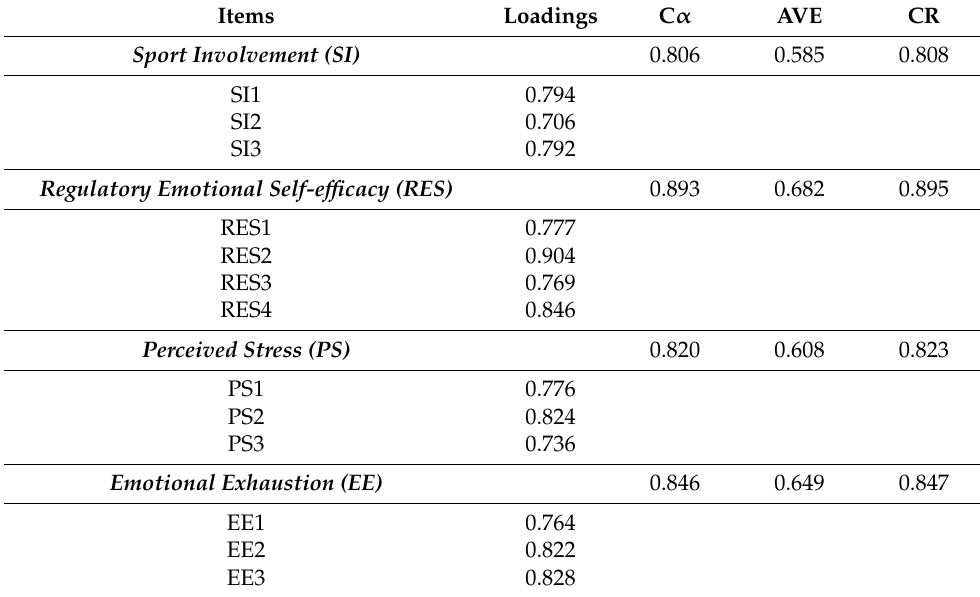
Table 2. Reliability and validity test.